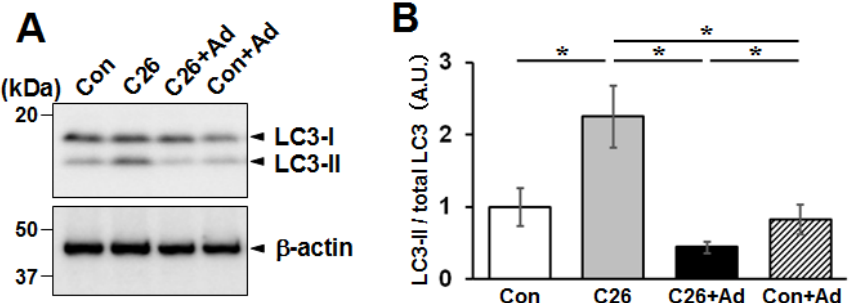
Figure 8. Effects of adiponectin treatment on LC3 expression. C2C12 myotubes were treated with C26-CM or adiponectin, and total proteins were analyzed by western blotting with anti-LC3 ( A ). Representative results from one of three independent experiments are shown. ( B ) Densitometric analyses of western blotting shown in ( A ) are presented in ( B ). The bar graphs indicate the mean LC3-II expression normalized by total LC3 (LC3-I+II) ± SD. Statistical analysis was performed by Kruskal-Wallis analysis followed by Mann-Whitney U tests. *: p < 0.05.